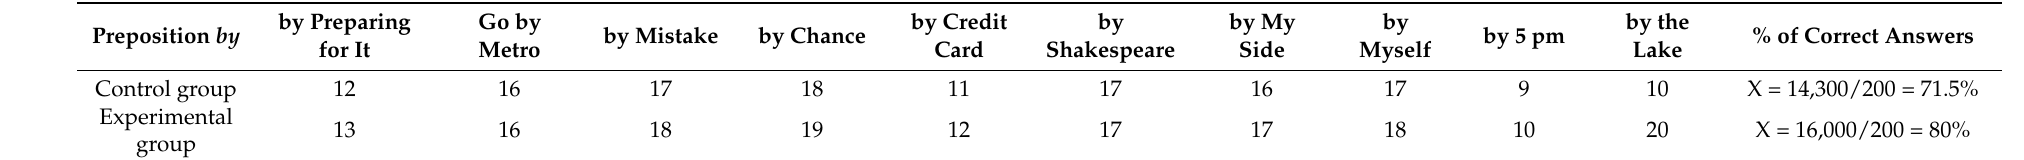
Table 13. Posttest 2 of the preposition by